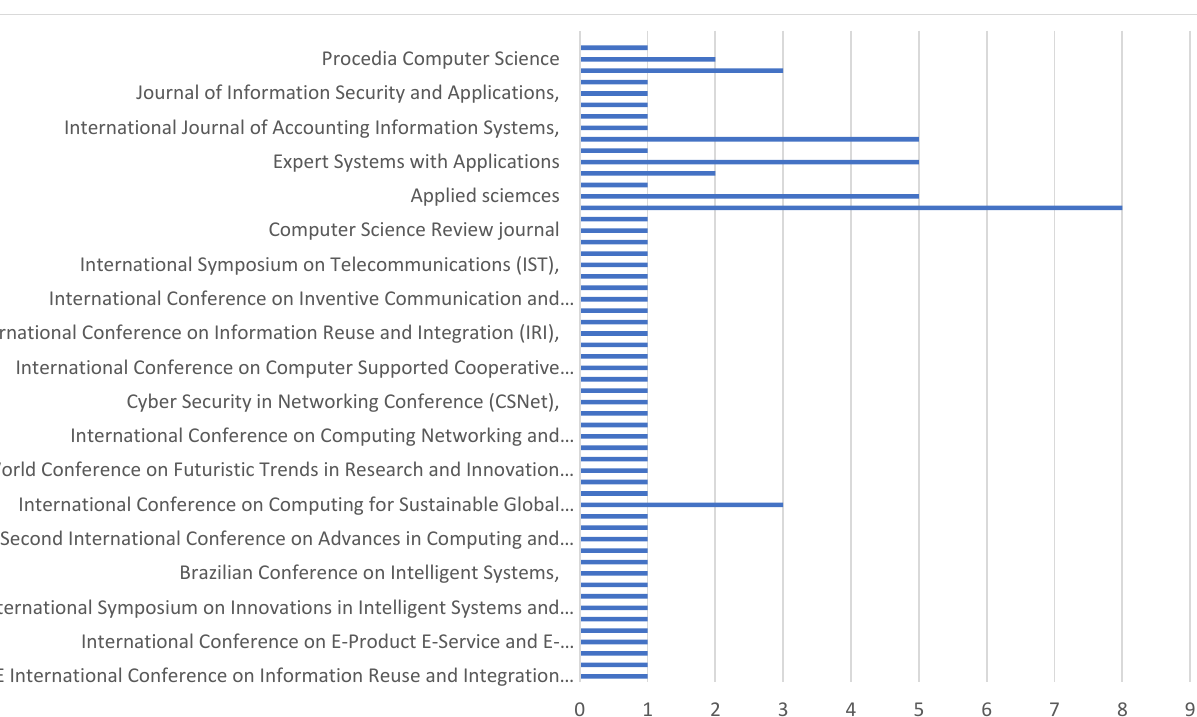
Figure 2. Summary of articles in a year.